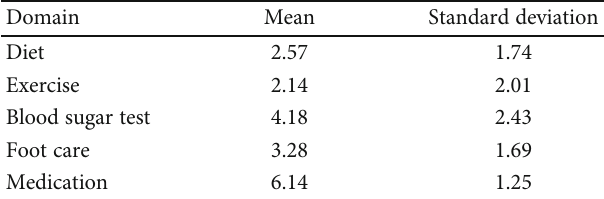
Table 2: Patient adherence to self-management